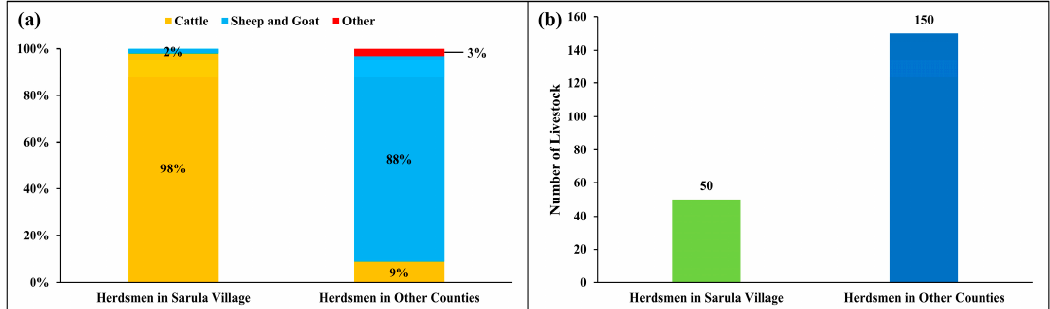
Figure 3. (a) livestock structure and (b) livestock number of Sarula village and other